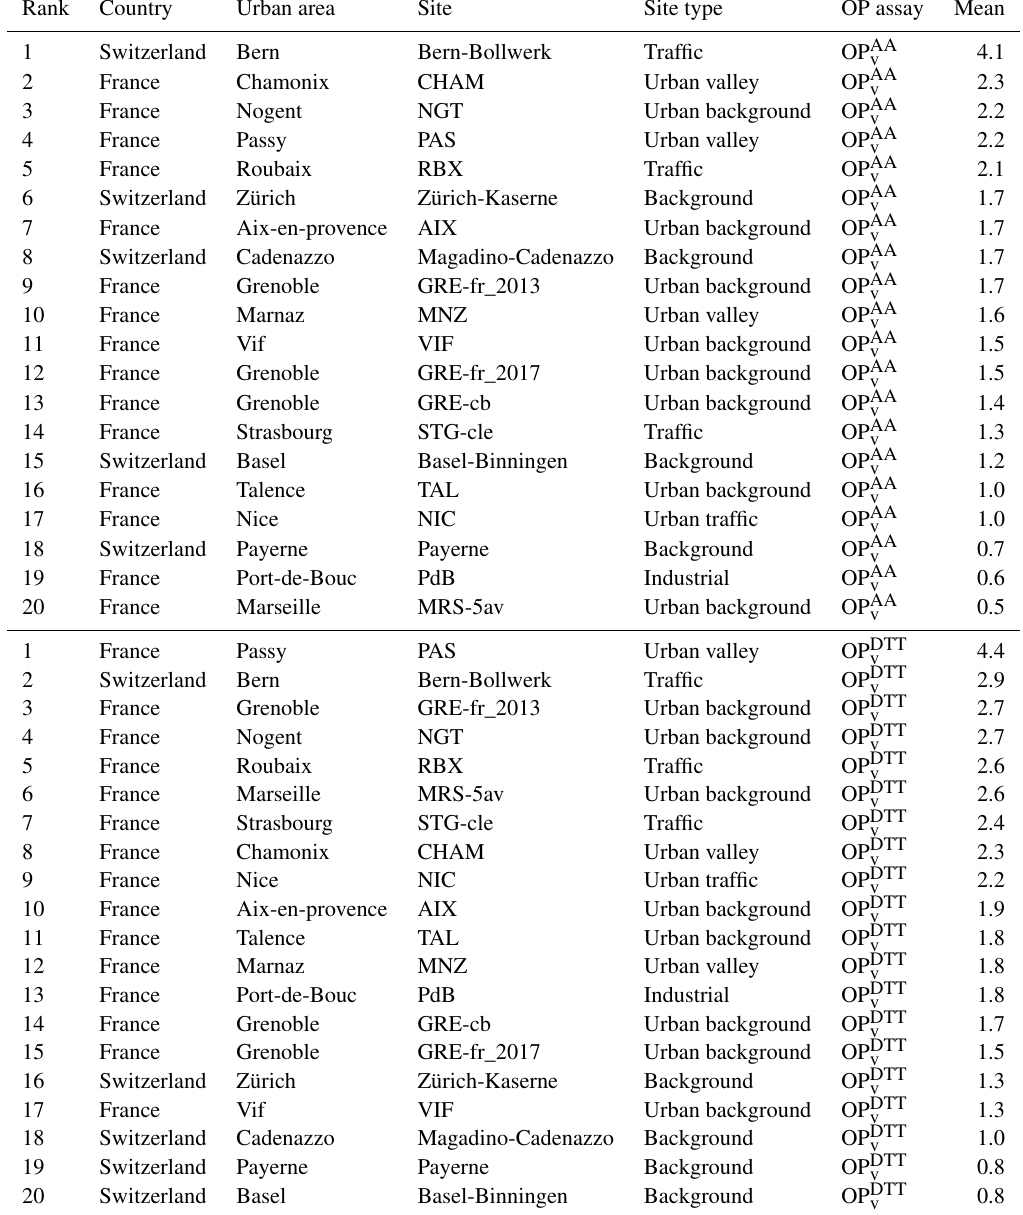
Table A1. Annual means of PM 10 OP AA v and OP DTT v for sampling sites in France and Switzerland where identical methods to quantify OP v were conducted. The units used for the means are nmolmin − 1 m − 3 and the data from 14 sites in France are from Weber (2021) and Weber et al.